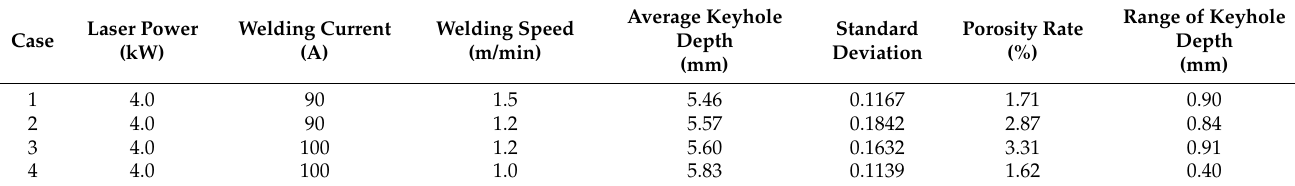
Table 4. Statistical data of keyhole steady-state fluctuation and porosity rate with different process parameters.